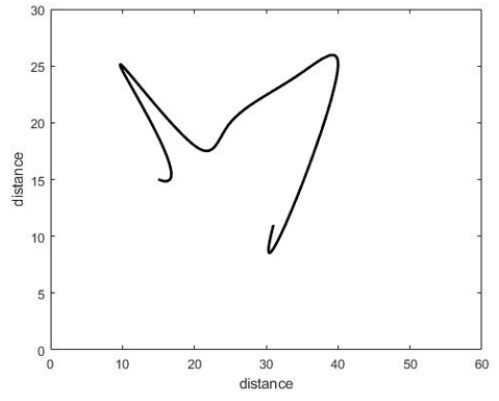
Figure 12. Partial normal path.